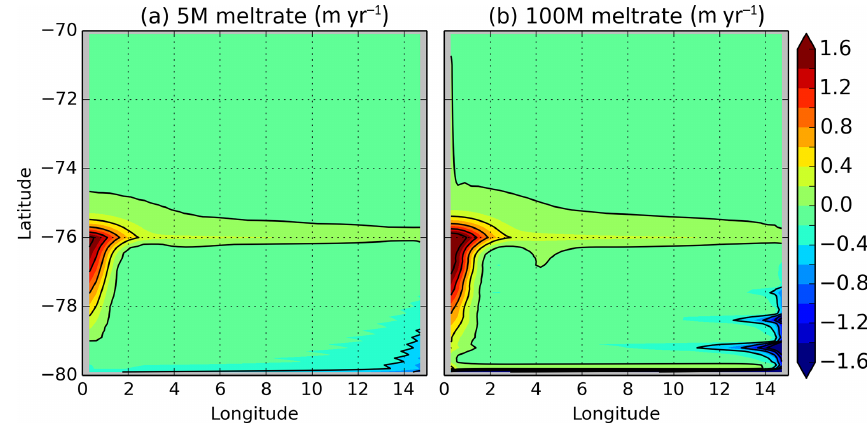
Figure 4. Melt rate in (a) the 5M simulation, and (b) the 100M simulation in myr − 1 (negative for melting and positive for freezing) with a contour interval of 0.4myr − 1